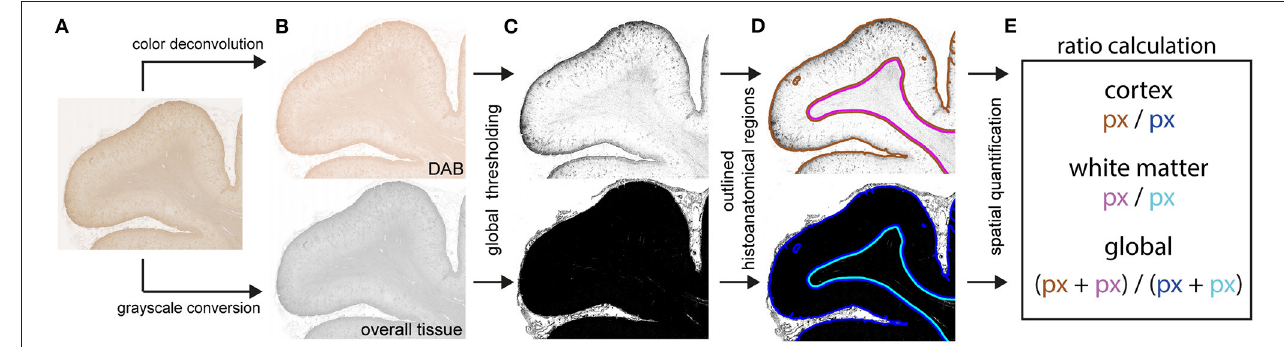
FIGURE 1 | Schematic procedure for digitally supported quantification of immunostaining intensities. Digitalized slides of immunostained brain tissue (A) were separately deconvoluted for DAB [ (B) , upper panel] and converted to grayscale [ (B) , lower panel]. Both acquired binary images were globally thresholded (C) with distinct value cut-offs. Pixel quantities were measured within manually assigned anatomical regions (D) . Assessment of immunostaining intensities (E) was based on ratios calculated from pixels with above-threshold values of the deconvoluted DAB image [ (C) , upper panel, DAB] over pixels with above-threshold value of the grayscale image [ (C) , lower panel, overall tissue] within their respective anatomical regions (D) .